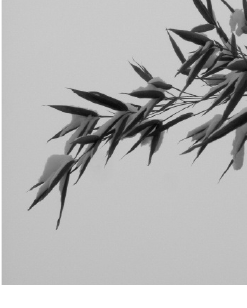
Figure 2. Bamboo covered in snow (Jane